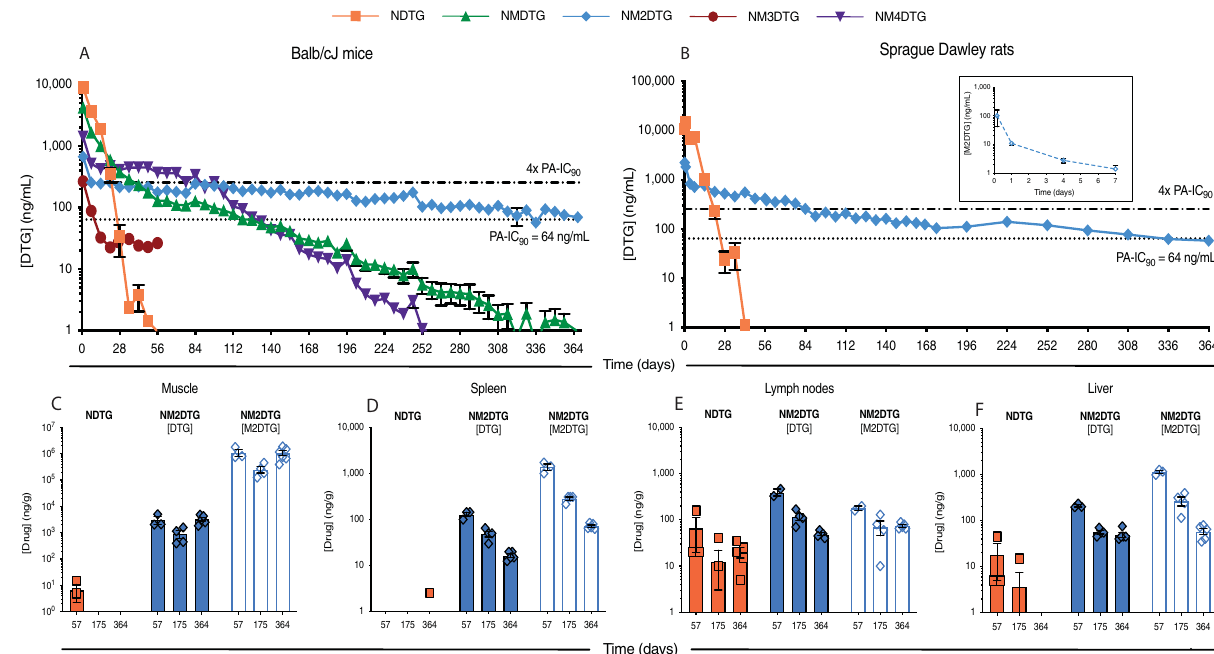
Fig. 3 DTG PK studies in Balb/cJ mice and Sprague Dawley rats. A Plasma DTG levels in male Balb/cJ mice administered a single intramuscular (IM) dose of NDTG, NMDTG, NM2DTG, NM3DTG, or NM4DTG. Drug formulations were injected at concentrations of 45 mg DTG-eq./kg IM in the caudal thigh and native drug levels were monitored for 367 days. Data are expressed as mean ± SEM. The study was initiated with N = 4 – 5 animals per treatment group ( N = 4 for NM3DTG, 5 for all others). Due to loss of animals by natural causes during study period, animals at day 367 are N = 5 (NDTG), N = 5 (NMDTG), N = 2 (NM2DTG), N = 4 (NM3DTG at day 56), and N = 5 (NM4DTG). The dotted line indicates the DTG protein-adjusted IC 90 (PA- IC 90 = 64 ng/mL) and dashed line indicates four-times the PA-IC 90 (4× PA-IC 90 = 256 ng/mL). B Plasma DTG levels in male SD rats administered a single 45 mg DTG-eq./kg IM dose of NDTG or NM2DTG in the caudal thigh were recorded (solid blue diamonds and line). Plasma prodrug (M2DTG) levels are shown in the insert (open blue diamonds and dashed line). Data are expressed as mean ± SEM. The study was initiated with N = 13 animals per treatment group (13 per group up to day 57, 9 – 10 per group up to day 175, and 5 – 6 per group up to day 364). One animal was lost from the NDTG group on day 140 during the study period due to natural causes. C – F Tissue biodistribution of NDTG and NM2DTG in SD rats was assessed on days 57 ( N = 3 animals per group), 175 ( N = 4 animals per group), and 364 ( N = 5 animals per group). Parent drug (DTG; solid blue diamonds) and prodrug (M2DTG; open blue diamonds) levels were determined in C muscle (at the site of injection), D spleen, E lymph nodes (pooled; cervical, axillary, and inguinal), and F liver. All drug levels were quanti fi ed by UPLC-MS/MS. Results are expressed as mean ± SEM. Exact values for each time point are provided in the Source